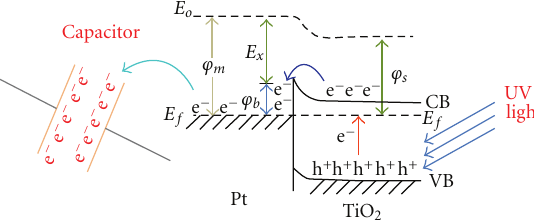
Scheme 2: Reaction mechanism proposed for the photocatalytic removal of MO